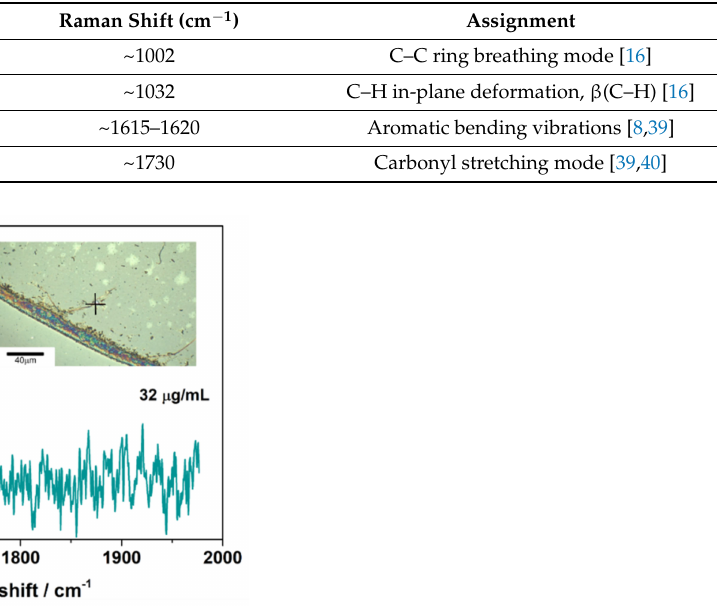
Figure A7. A Representative SERS spectrum obtained for 62 nm PET nanoparticles on 14 nm AuNP substrates. The spectrum is shown with an image of the region of interest (ROI) the measurement was obtained from. Scale is 40 µ m. Laser power, scan speeds, and number of averaged accumulations for the samples can be viewed in Table A1.